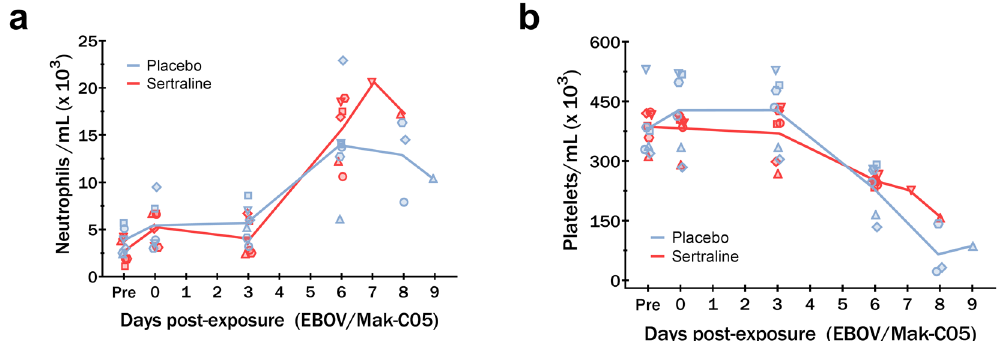
Figure 2. Neutrophil and platelet counts for sertraline hydrochloride and placebo treated animals. Pronounced neutrophilia and thrombocytopenia was observed in all animals by day 6 post exposure. Animals were treated with 200 mg sertraline hydrochloride (red) or placebo (blue) by orogastric tube. Group means are presented as lines, with individual values depicted as